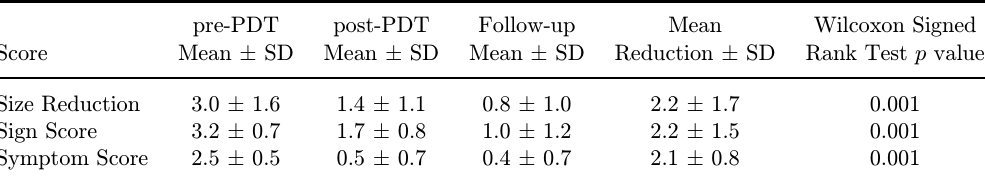
Table 4. Mean of sign, symptom scores and size reduction on pre-, post-PDT and follow-up of the OLP lesions.